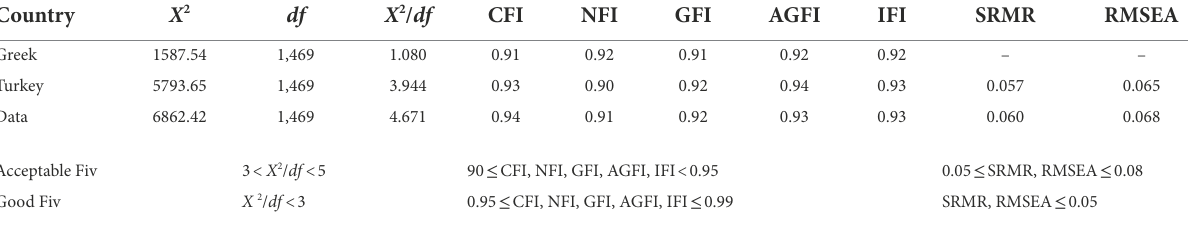
TABLE 3 Fit index values as a result of CFA analysis applied to the data set. Country